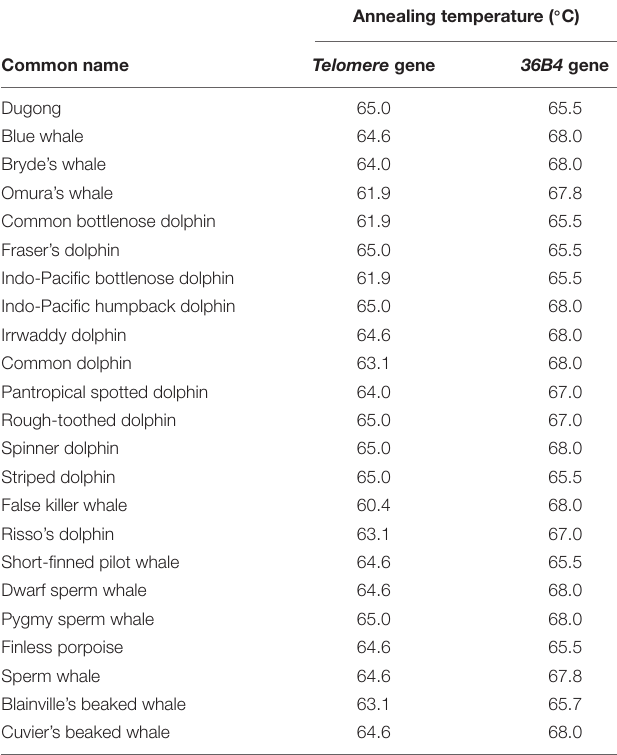
TABLE 2 | Annealing temperature of telomere primer and single copy gene